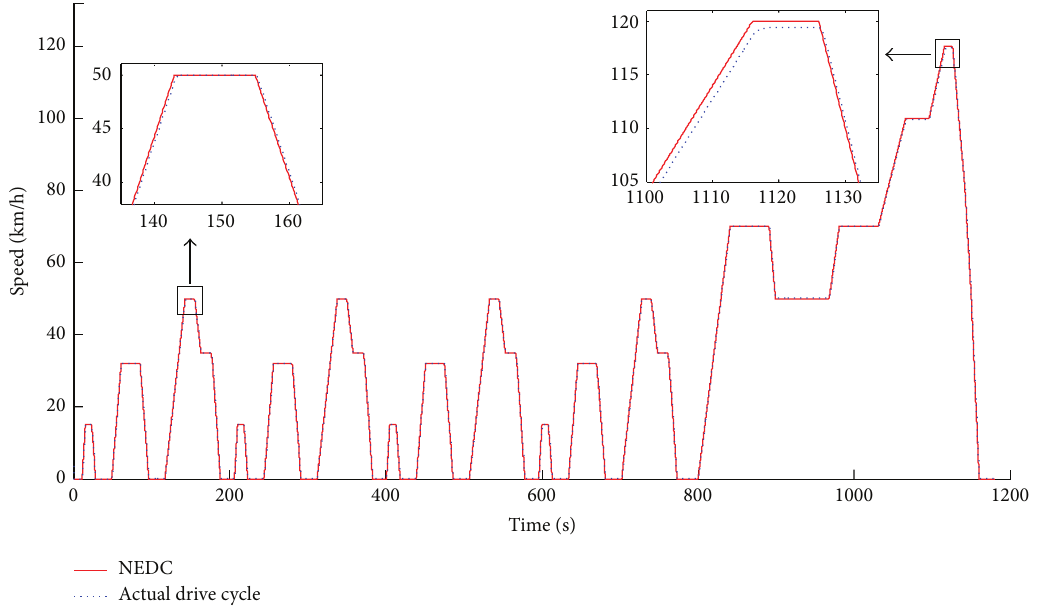
Figure 13: The NEDC and actual following